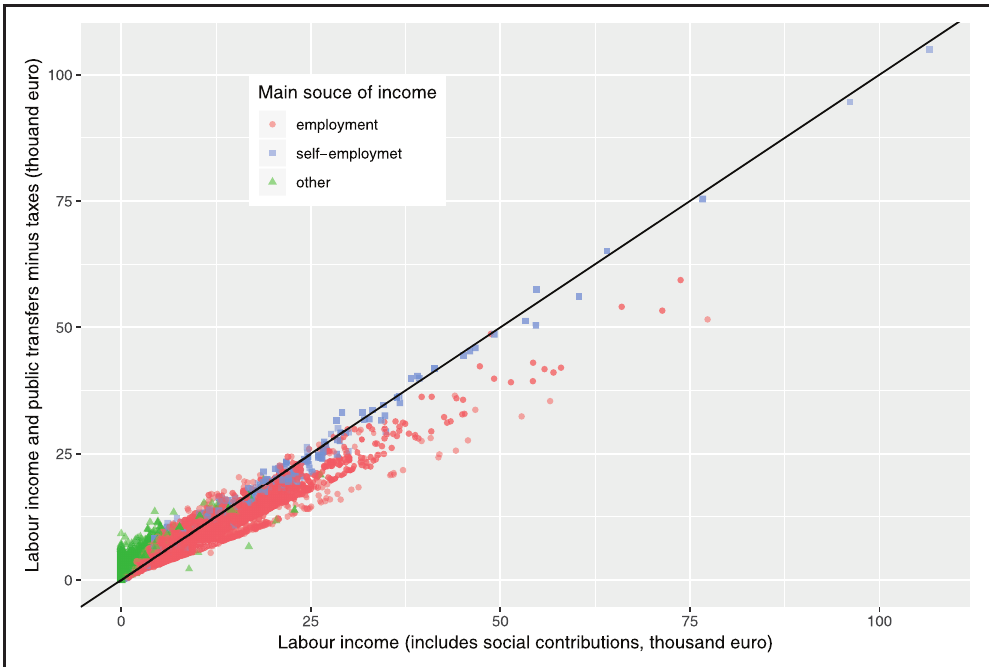
Figure 4 Effective equivalized incomes of households grouped using the income definition in